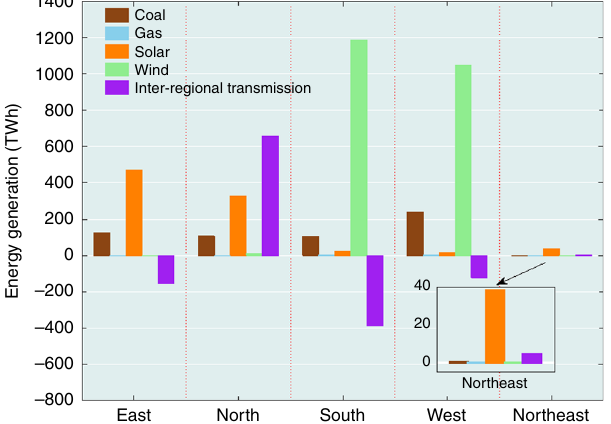
Fig. 3 Regional energy generation distribution. Regional distribution of energy generation for different power sources for 2040 inferred using the standard model assuming 80% commitment of renewables. Data identi fi ed as interregional transmission refer to interregional transfers of power for the existing and newly expanded transmission network. Negative values identify exports; positive values imports.